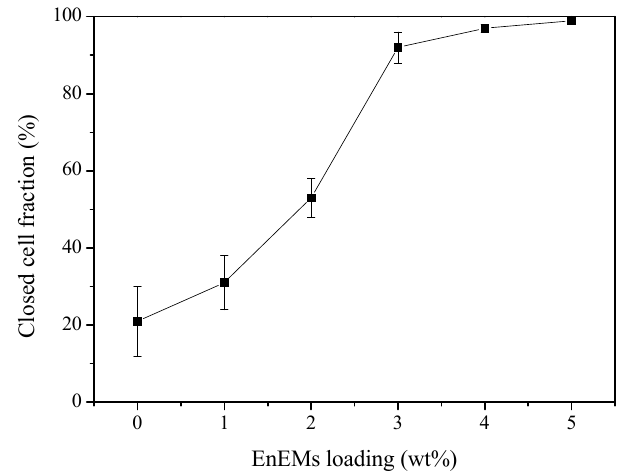
Figure 9. Closed cell fraction of poly(butylene succinate) (PBS) foams as a function of endothermic expandable microsphere (EnEMs)/AC loading ratio, reproduced from [115] with permission, copyright Elsevier, 2018.